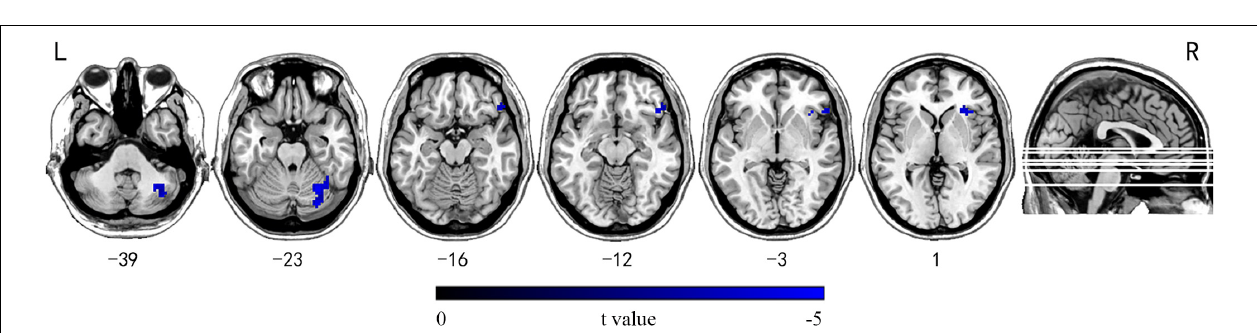
FIGURE 2 | Brain regions showing significantly decreased INT between mTLE patients and HC subjects. Group differences in INT between the mTLE and HC groups were identified using a two-sample t test. The statistical significance level was set at voxel-wise p < 0.001, cluster-level p < 0.05 (GRF corrected, voxel wise ≥ 30). Patients with mTLE showed decreased INT in the right inferior/middle OFG, right insular, and right cerebellum crus1/crus2/6. INT, intrinsic neural timescales; HC, healthy control; mTLE, mesial temporal lobe epilepsy; OFG, orbital frontal gyrus; L, left; R, right.